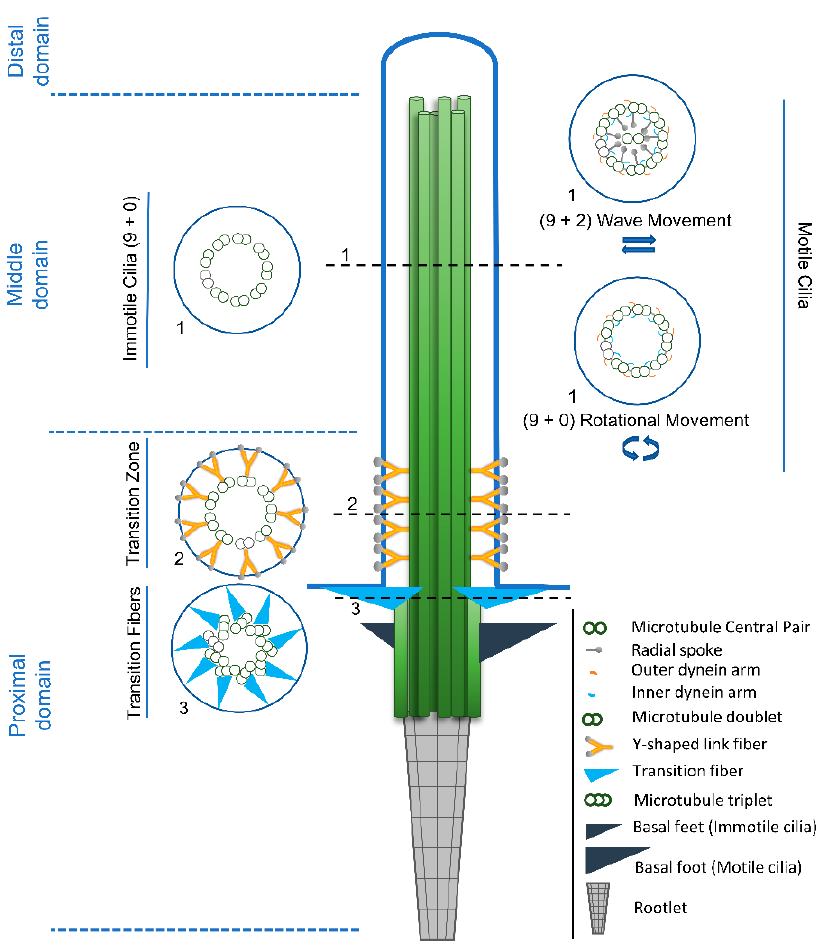
Figure 1. Structural comparison between motile and primary cilia. The cilia axoneme is composed of nine pairs of microtubules (green tubules) that extend from a modified centriole named basal body. Three structural and functional cilia domains can be identified, namely the distal, the middle and the proximal domains, according to their position in relation to the basal body. Cross-section 1 shows the three most common axonemal architectures: (9+0) immotile and motile cilia, with nine microtubule doublets arranged radially; (9+2) motile cilia, with nine microtubule doublets and a central pair of microtubule singlets. Motor proteins (outer dynein arms (yellow) and inner dynein arms (blue)) together with radial spokes generate the wave-like beating of the (9+2) motile cilia; (9+0) motile cilia, with nine microtubule doublets and without central pair of microtubule singlets. In (9+0) motile cilia, motor proteins (outer dynein arms (yellow) and inner dynein arms (blue)) generate a rotational movement. Cross-sections 2 and 3 respectively show, the Y-shaped links (yellow) of the transition zone and the transition fibers (light blue), that link to the membrane creating the ciliary gate. The rootlet (grey) extends from the base of the basal body towards the nucleus and appears as long striated fibers. The basal foot (motile cilia)/basal feet (immotile cilia) (dark blue) provide additional support to the cilia. In the case of motile cilia, the basal foot aligns with the cilia beating direction.